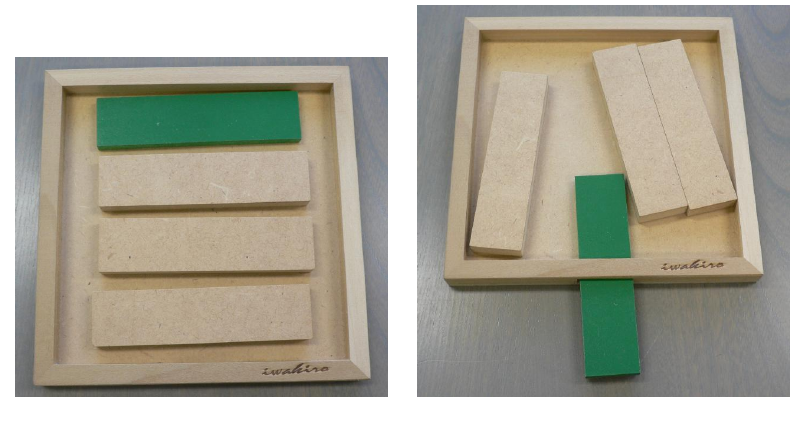
Figure 10. A difficult puzzle that consists of four rectangles and one nonrectangle frame.